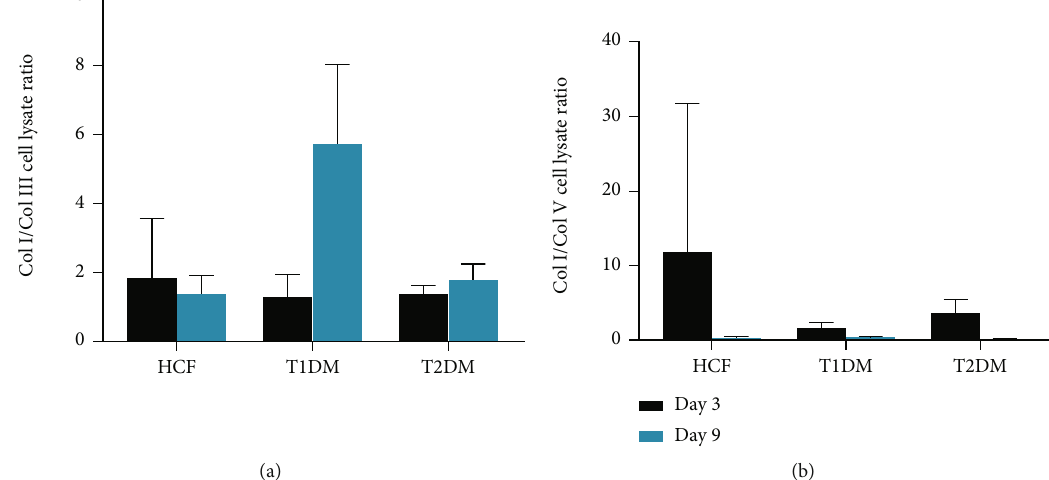
Figure 3: Lysate ratios of (a) Col I/Col III and (b) Col I/Col V. Welch ’ s unpaired t -test and/or ordinary one-way ANOVA ( n = 4 ) was used to analyze the results. Error bars represent standard deviation.